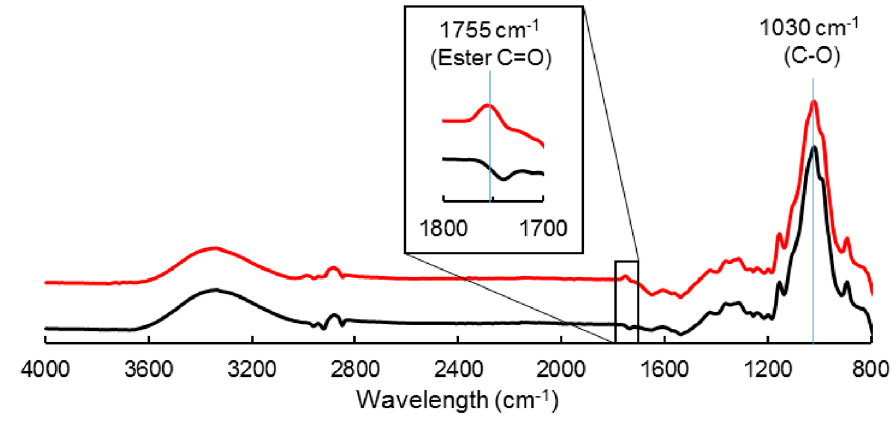
Figure 1. FT-IR spectra of C-virgin ( ‒ ) and C-grafted ( ‒ ).